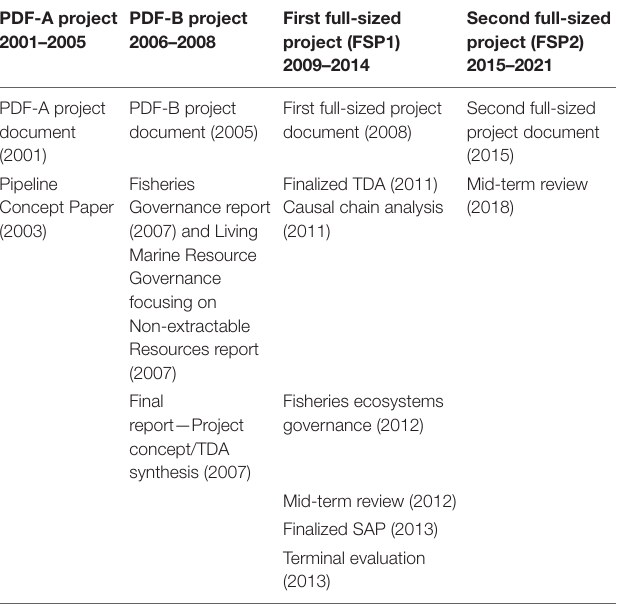
TABLE 2 | List of reviewed project-related